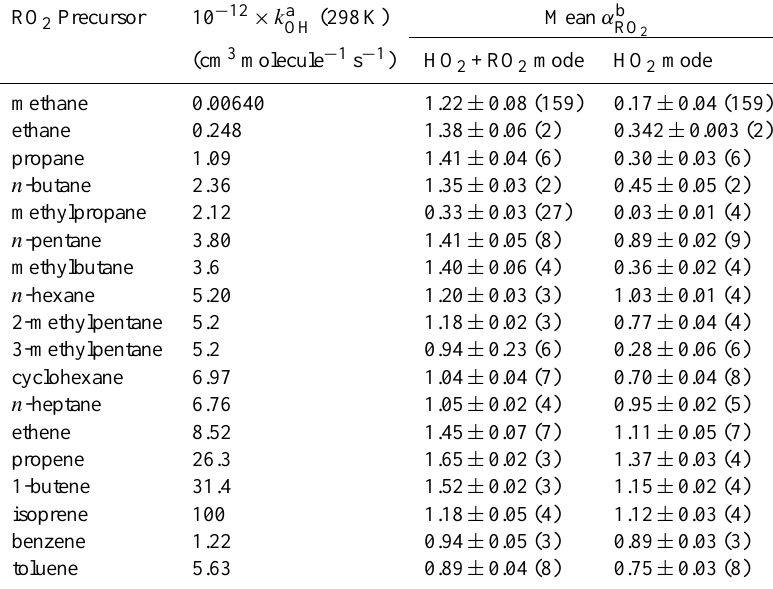
values from studied RO 2 2